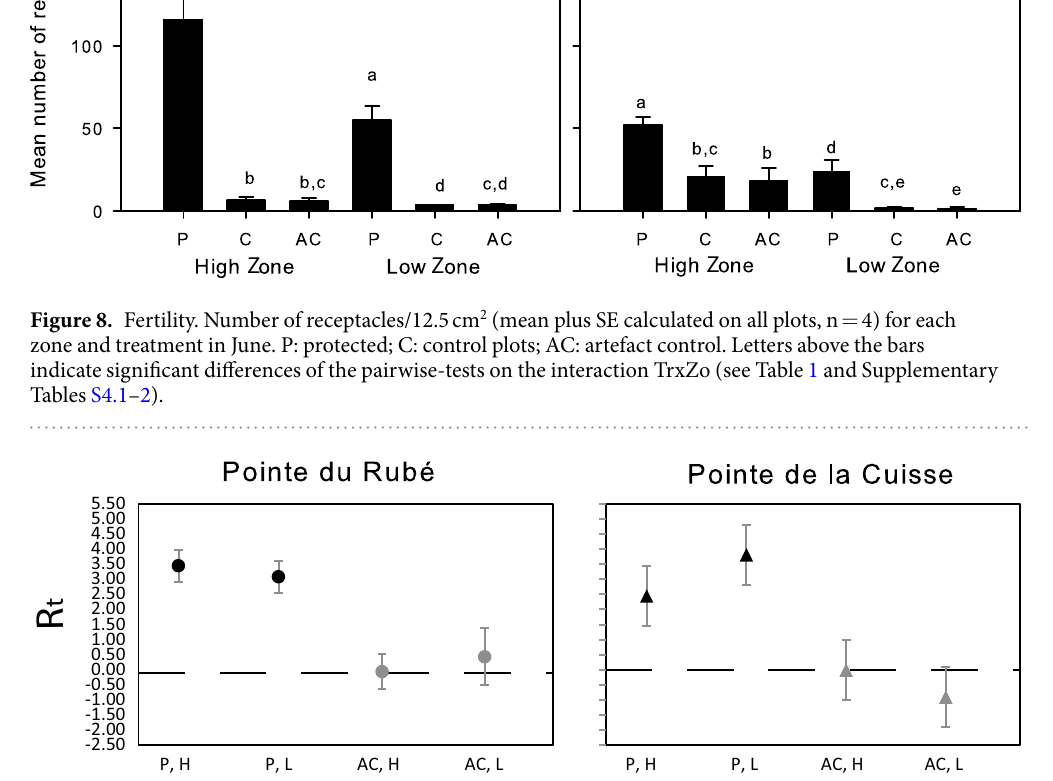
Figure 9. Effect sizes of protection and zones based on the reproductive potential. Protection (P: protected, AC: artefact control), Zones (H: High, L: Low). R t : log-response ratio for each